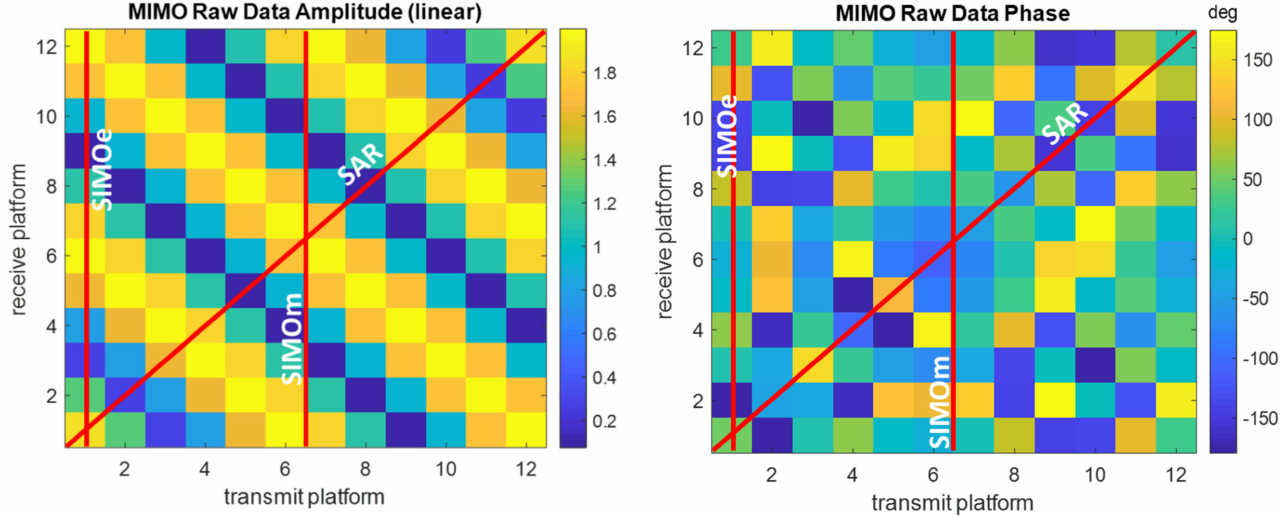
Figure 17. Complex raw data amplitude and phase for SAR, SIMO (SIMOe and SIMOm), and MIMO modes for the example 1D simulation with two targets separated by 20